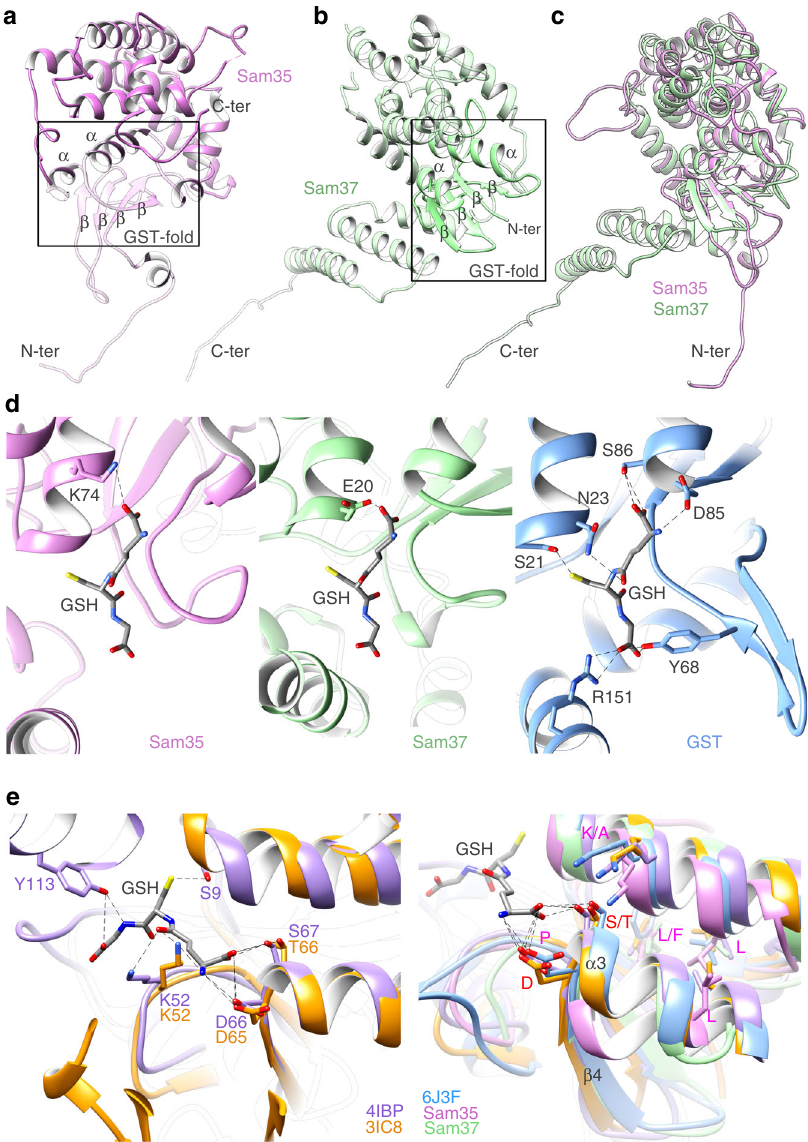
Fig. 4 Analysis of the GST-like fold for Sam35 and Sam37. a Ribbon view of Sam35 exhibits a canonical GST fold of an α / β domain at the N-terminus and an all α -helical C-terminal domain. b Ribbon view of Sam37 shows a con fi guration similar to Sam35 with an N-terminal α / β domain with an all α -helical C-terminal domain. c Superposition of Sam35 (orchid) and Sam37 (pale green) shows high structural similarity. d Close-up of the pseudo active site in Sam35, Sam37, and the genuine active site of GST (PDB:6J3F). Hydrogen bonds are shown as dashed lines. e Close-up views of the residues related to the active site of GST. Left: superposition of two GST-like proteins (left; PDB:4IBP and PDB:3IC8). Right: superposition of GST (PDB:6J3F), the same two GST- like proteins (PDB:4IBP and PDB:3IC8), Sam35 (orchid), and Sam37 (pale green). The bound GSH is shown in gray. The active site residues conserved among all the above structures are labeled in magenta, whereas residues only present in GST and GST-like proteins are labeled in